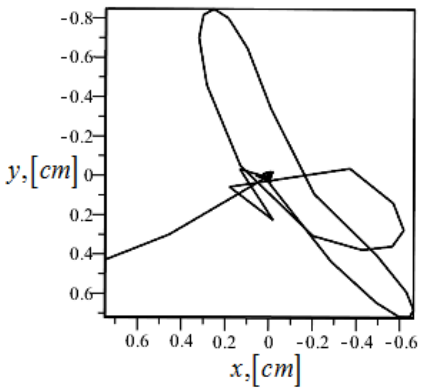
Figure 3. Trajectory of the moving ball in three-dimensional dimensions for the initial conditions: